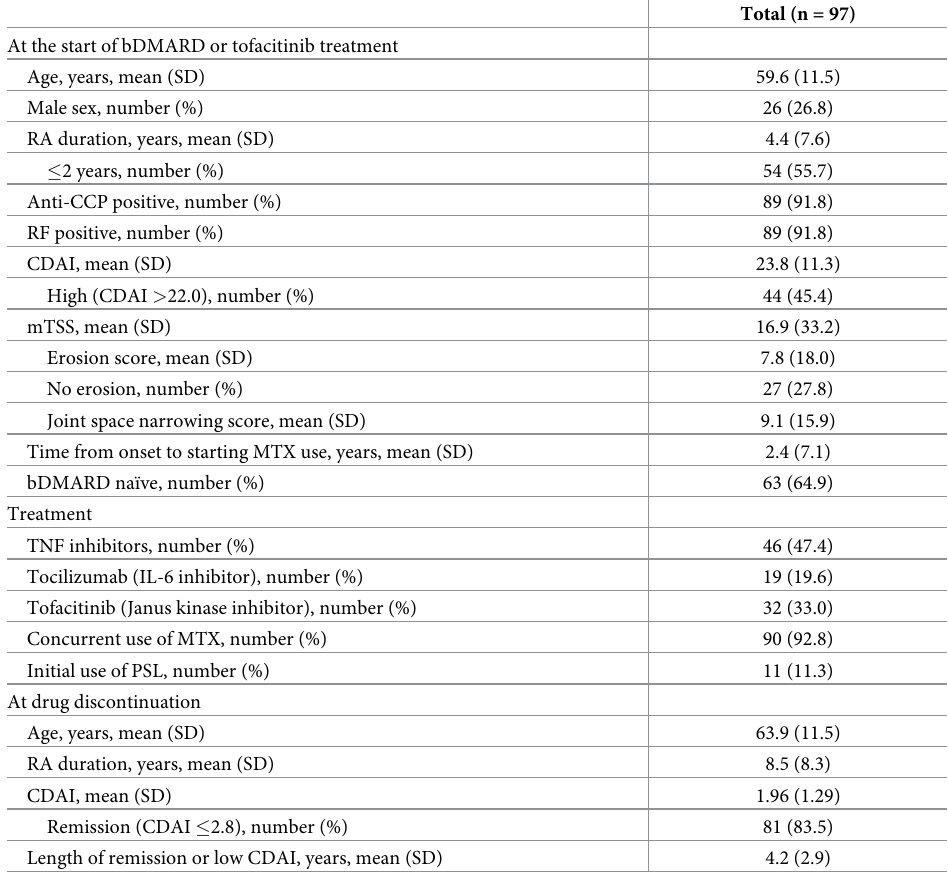
Table 1. Clinical characteristics of RA